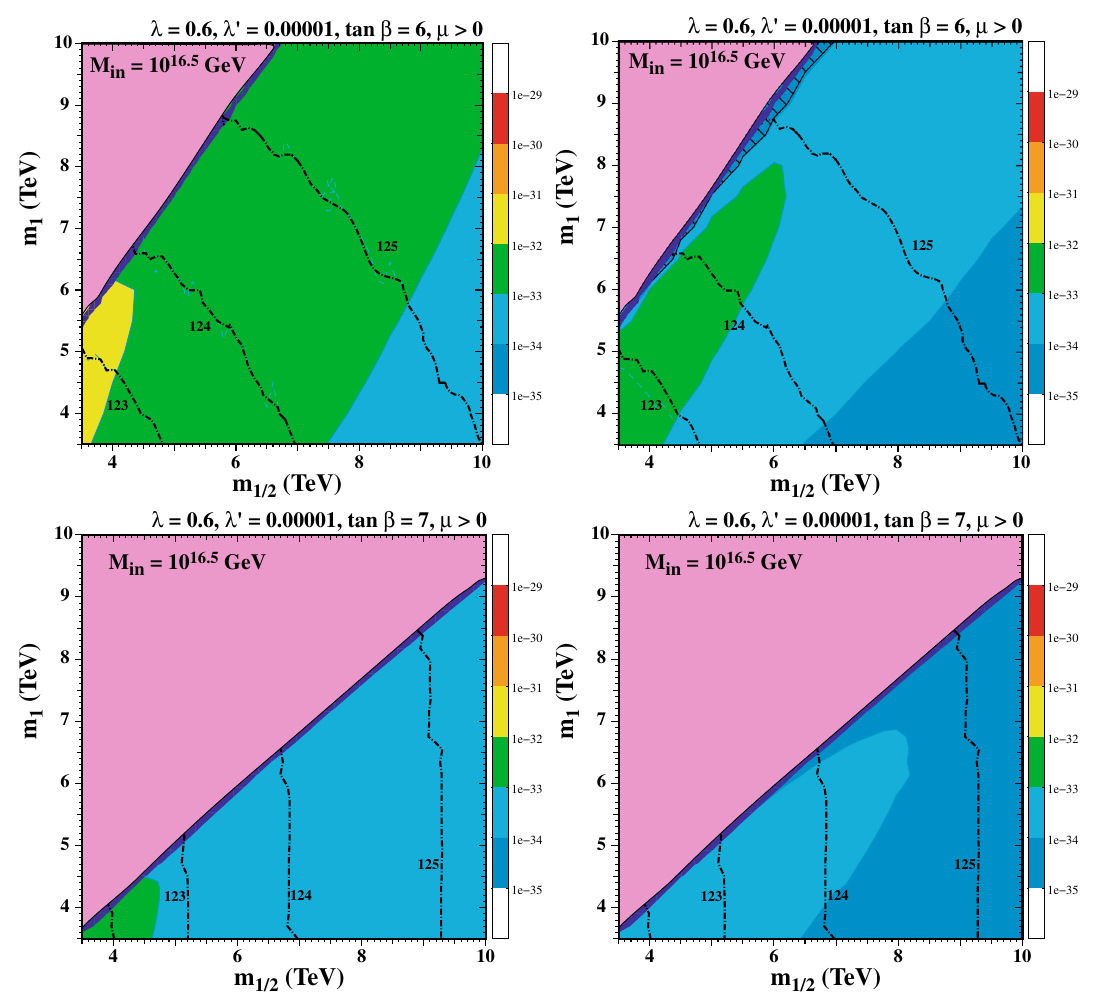
Fig. 8 As in Fig. 5, showing values of the electron EDM for the flavor choices A (left) and B (right) in model M1 with M in = 10 16 . 5 GeV and tan β = 6 (upper panels) and in model M2 with M in = 10 16 . 5 GeV,